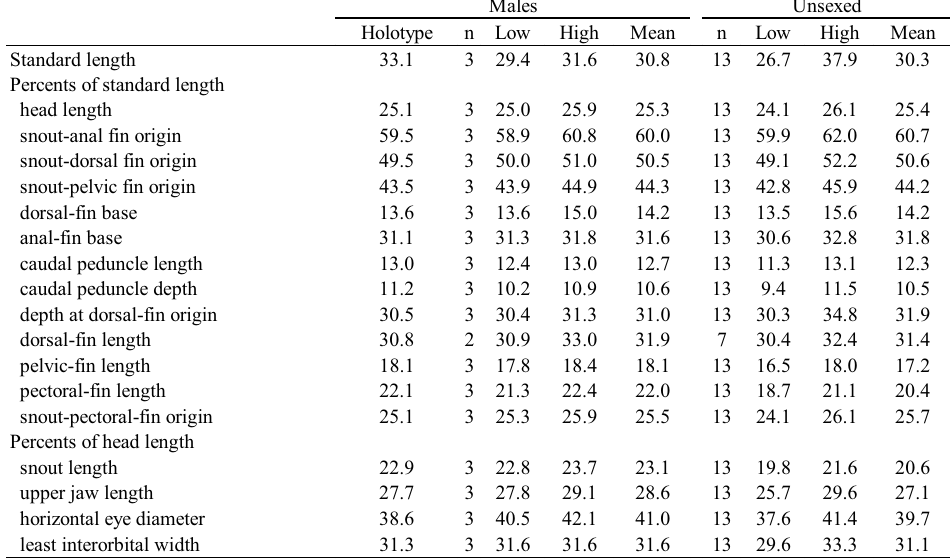
Table 3. Morphometrics of Odontostilbe nareuda n. sp. (holotype CBF 09621, paratypes 5 of FMNH 106433, 1 of